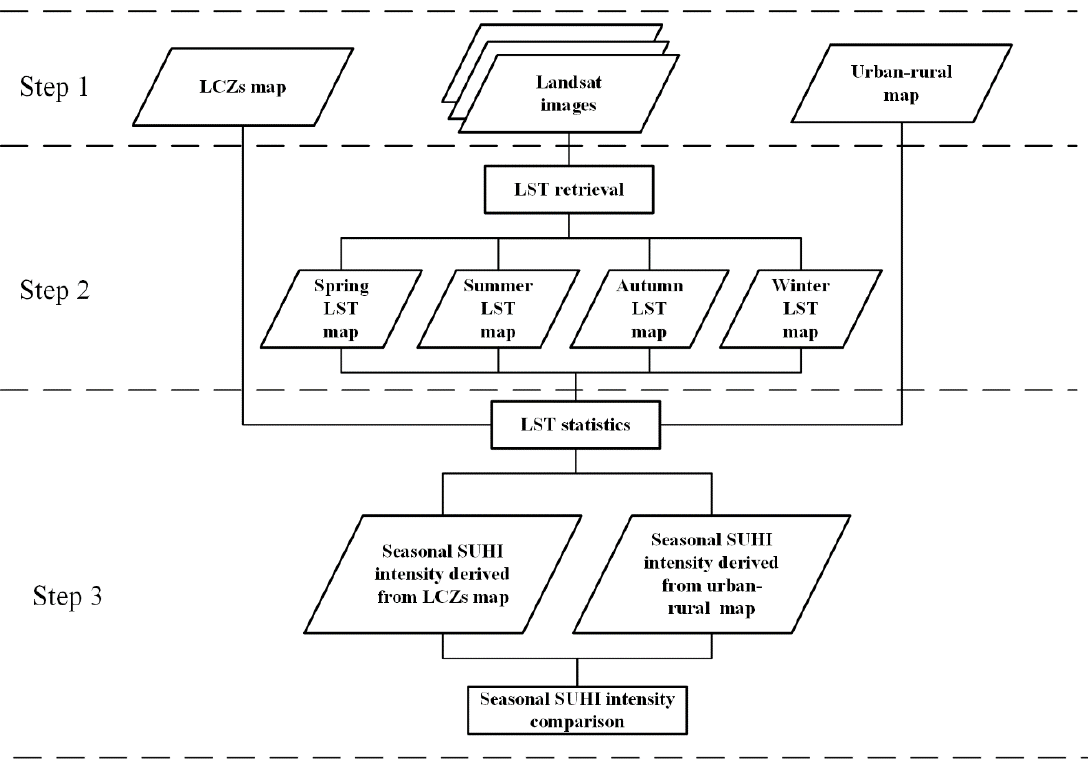
Figure 3. The flowchart of seasonal SUHI analysis.